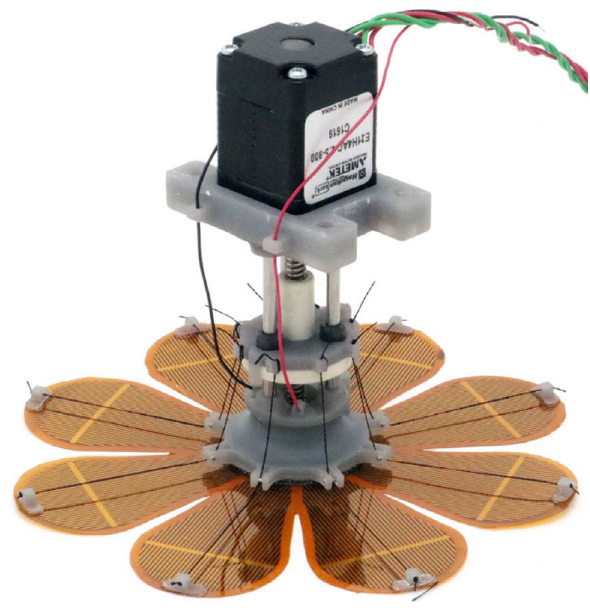
Fig. 1 Example of the design of an electrostatic gripper [4]